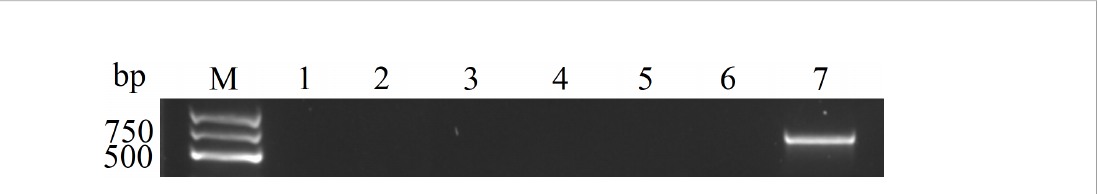
FIGURE 1 PCR results of different virus with TNFR primer (PCR-F/R). 1, SVCV; 2, GCRV; 3, IHNV; 4, KHV; 5, CyHV-2; 6, negative control (water); 7, CaHV. M: DNA Marker (100~2000